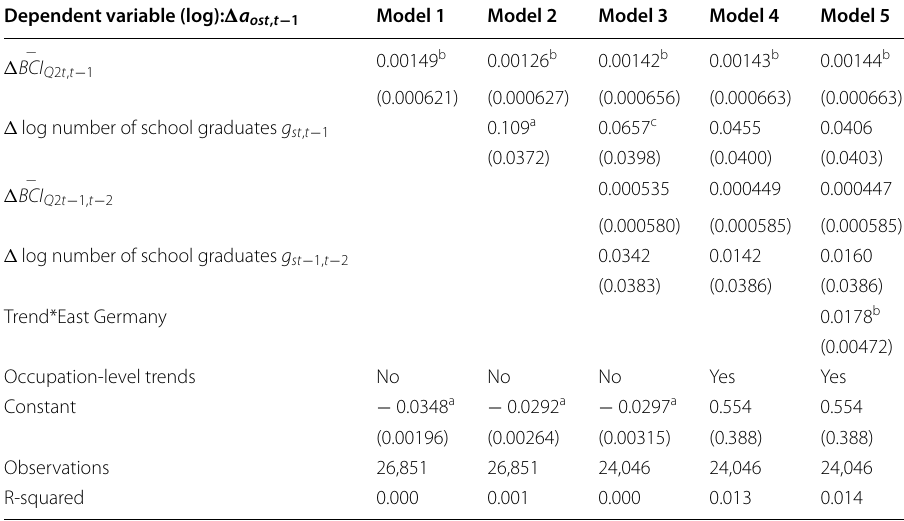
Table 11 First-differences regression (occupation-state-level, apprentices with low-level school degree)